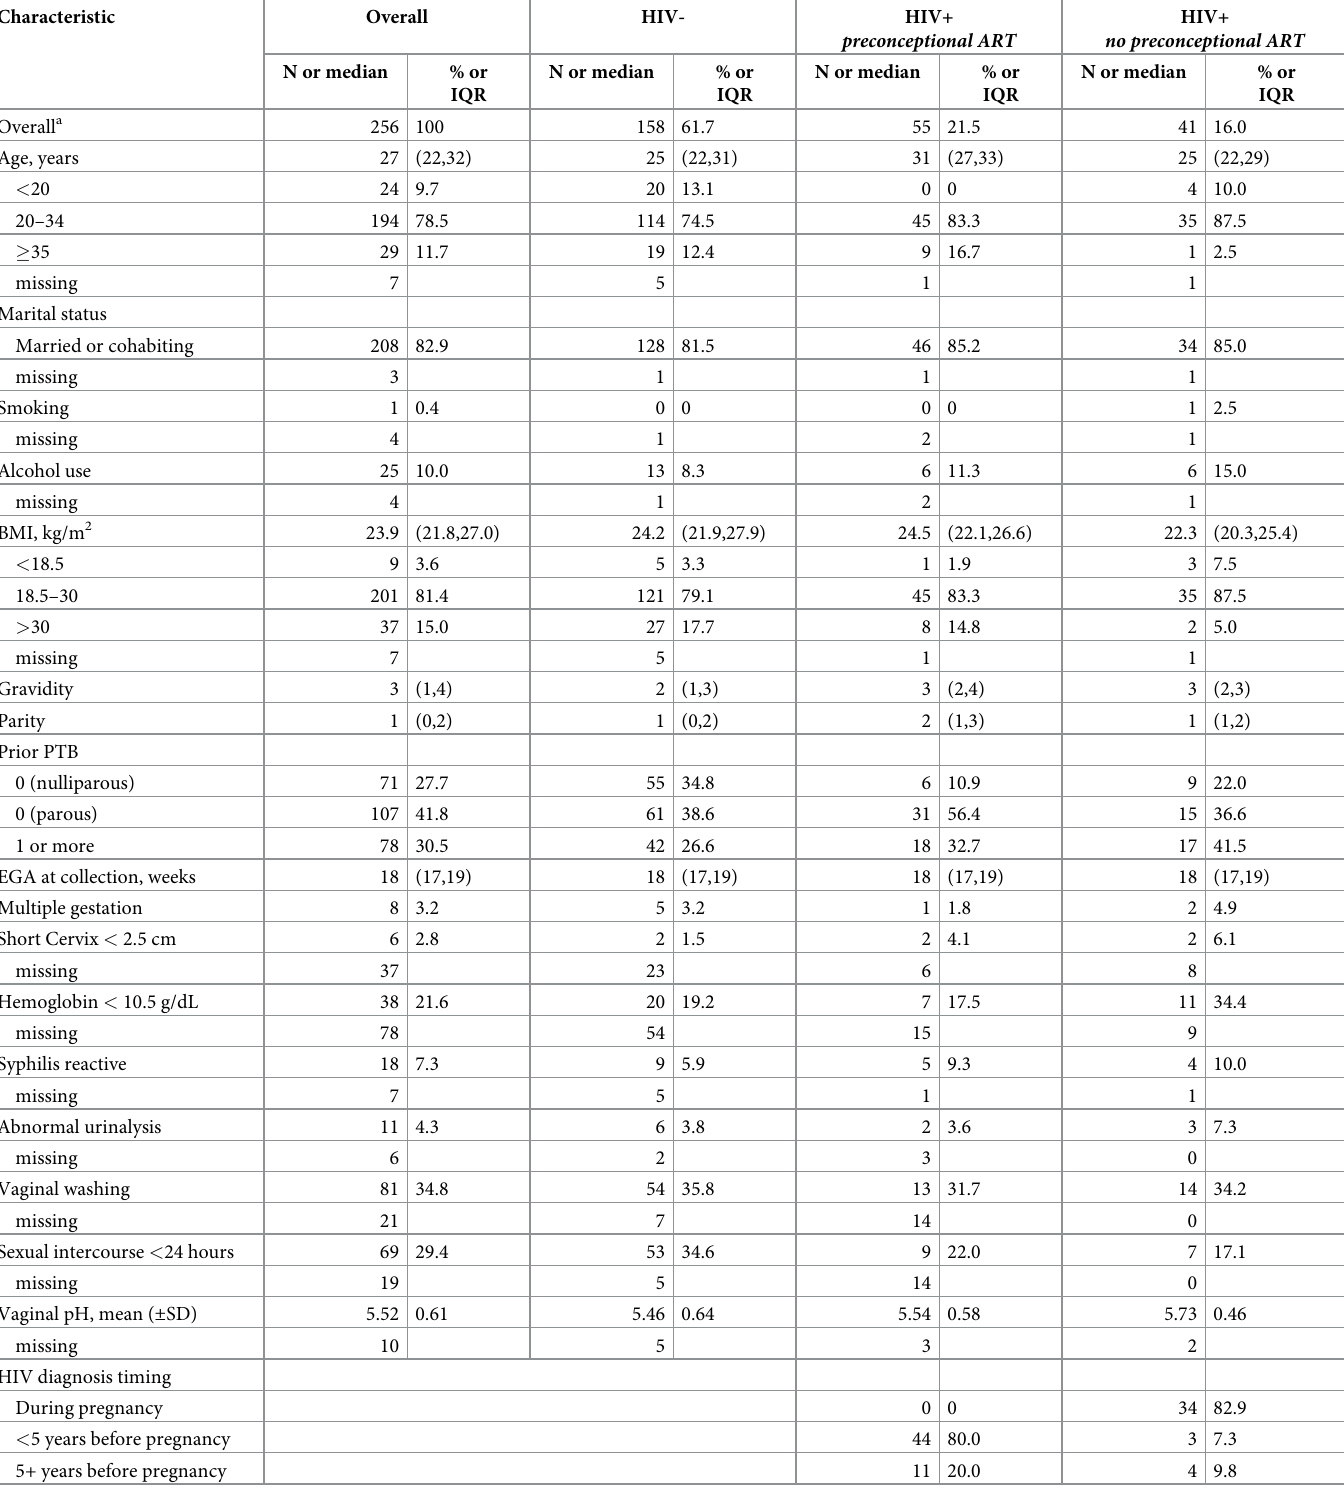
Table 1. Baseline characteristics of participants with evaluable bacterial sequences, N =